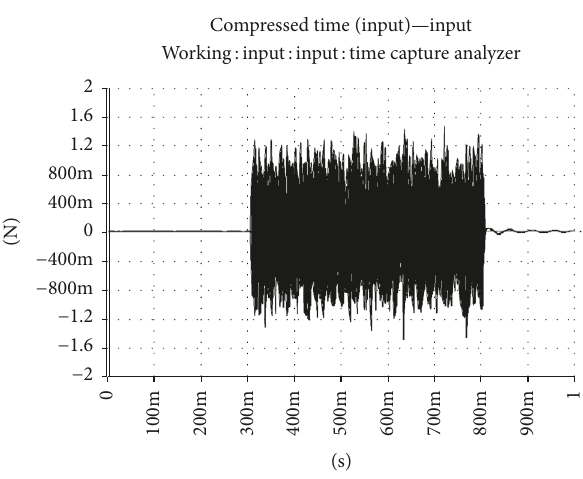
Figure 12: The input random signal in time